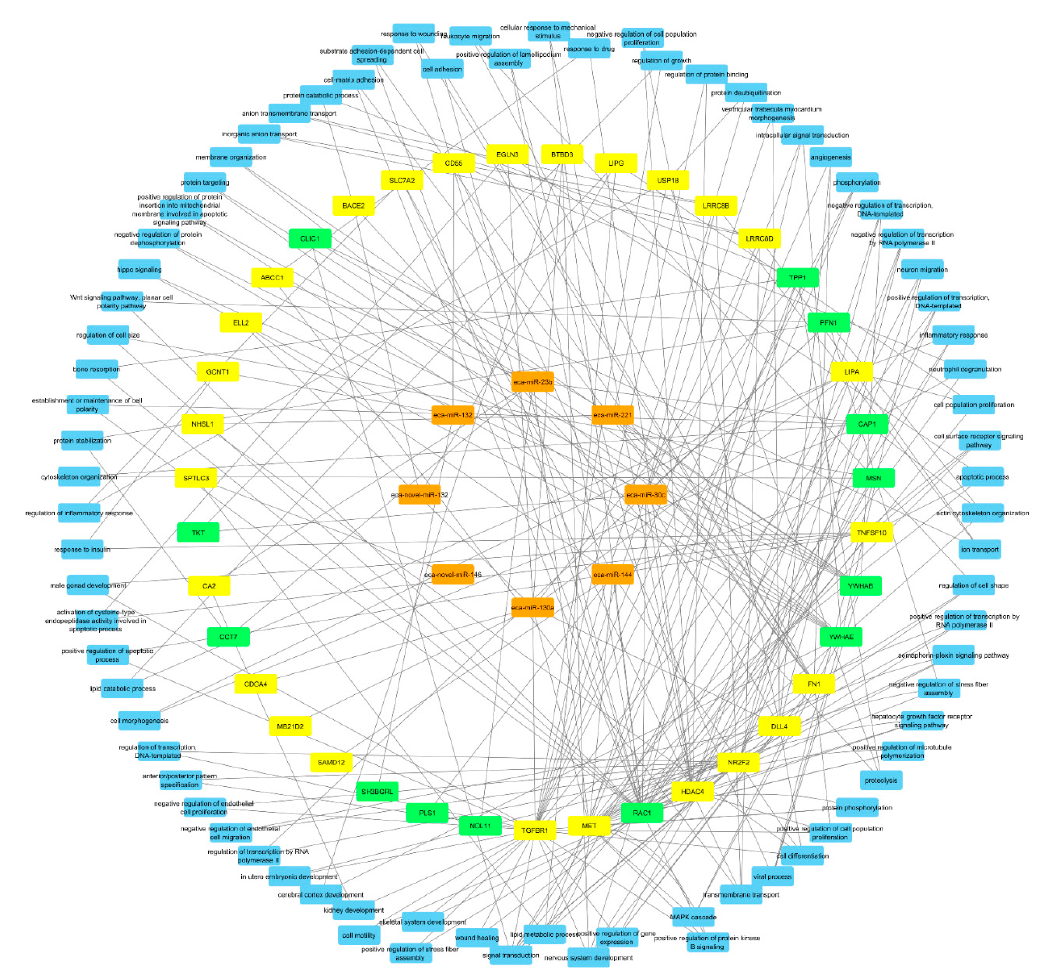
Figure 4. Interaction between differentially expressed miRNAs (orange), mRNAs (yellow) and proteins (green) in pregnant vs. cyclic mares 13 days after ovulation. Common Gene Ontology biological processes in which two or more molecules are involved are displayed in blue.